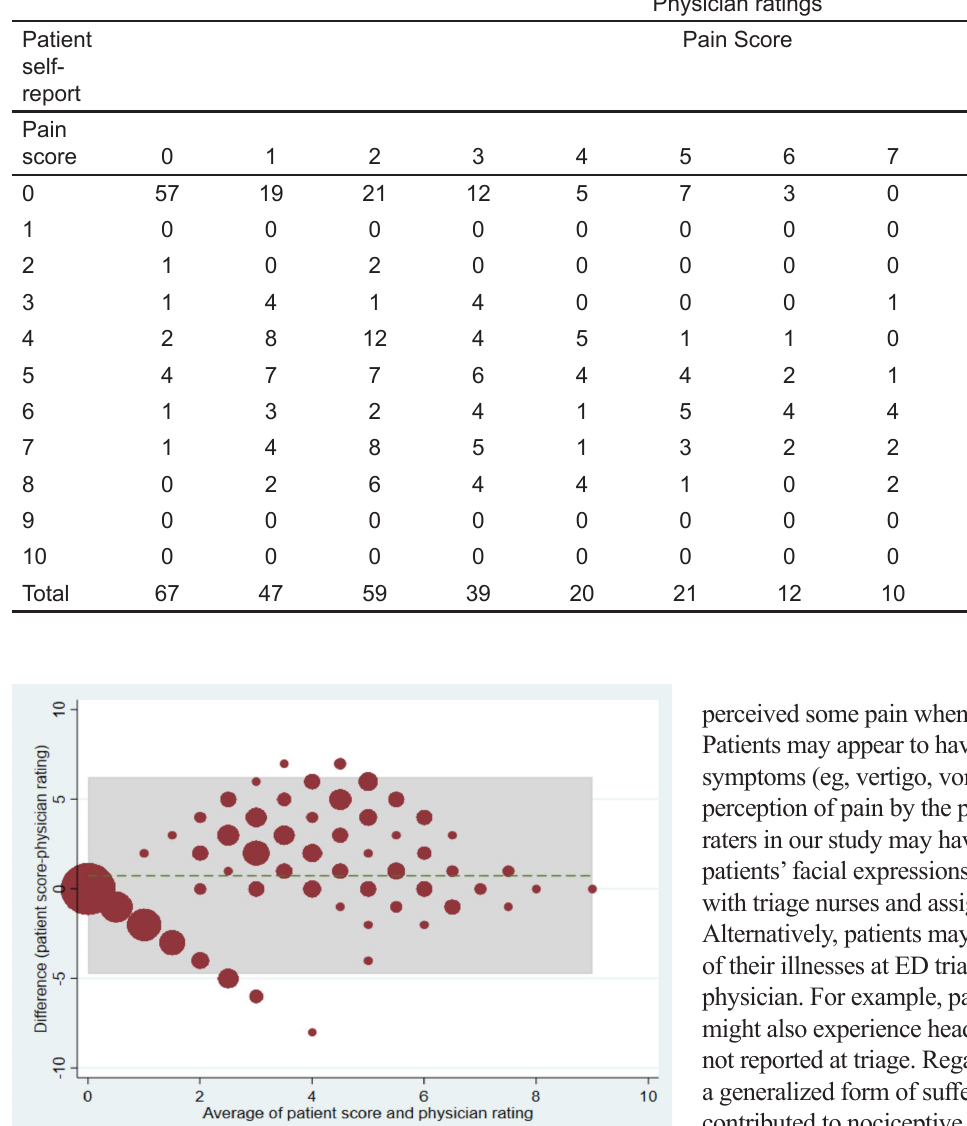
Figure 3. The Bland-Altman plot of the agreement between self-reported pain scores and physicians’ ratings of pain. The green line represents the mean difference between the patient and physician scores. The shaded box is bounded by the statistical limits of agreement (defined as the mean difference ± 1.96 SD of